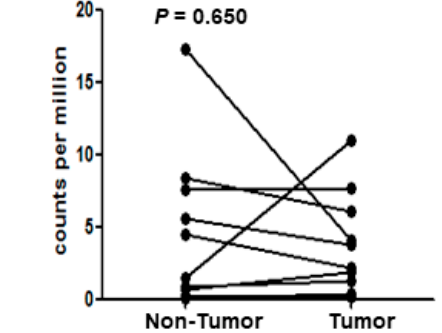
Figure 8. Discovery of the novel miRNA. ( A ) Stem-loop structure of the novel miRNA (miR-X) precursor predicted by mfold version 3.6. The mature miRNA sequence is shown in red. The minimum free energy (MFE; ∆ G) of hairpin structure and the genomic coordinate of the mature sequence are indicated. ( B ) Symbols and line graphs showing relative expression (counts per million) levels of miR-X in paired tumor and non-tumor lung adenocarcinoma (left panel) or squamous cell carcinoma (right panel) tissues. p -values are